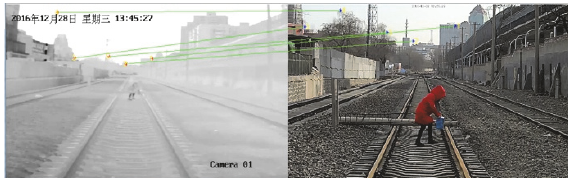
Figure 6: Refining result of similar triangle constraint.